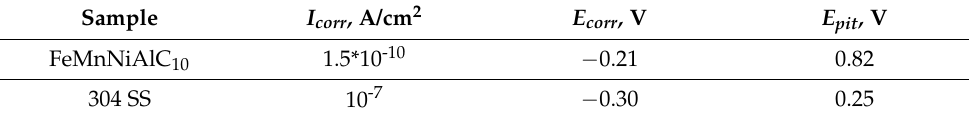
Figure 4. Potentiodynamic polarisation curves for 304SS and FeMnNiAlC 10 HEATF. Table 3. Corrosion parameters obtained from potentiodynamic polarisation.